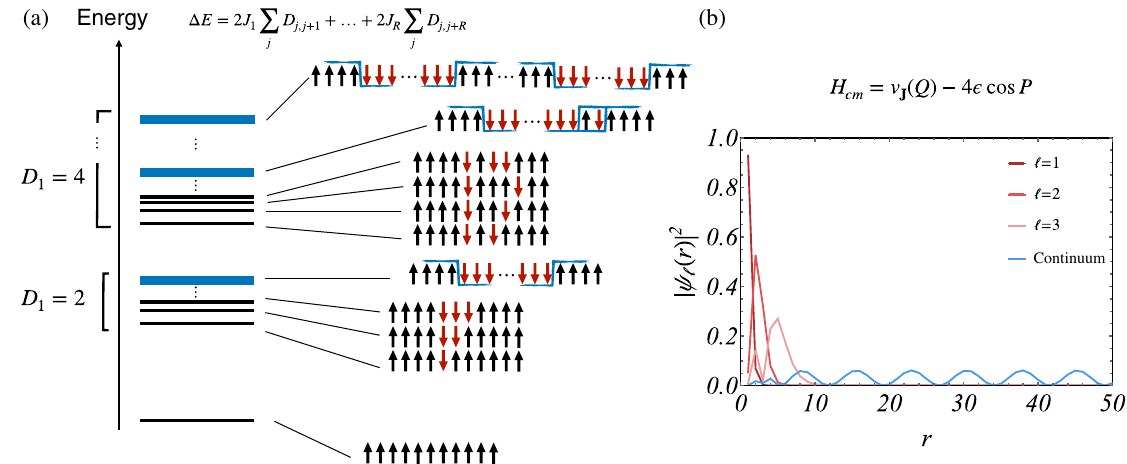
FIG. 8. (a) Sketch of the eigenstates of the Floquet Hamiltonian H F for ϵ → 0 . The vertical axis represents the excitation energy Δ E above the Floquet ground state. (b) Selection of eigenstates of the two-body problem (47) in the center-of-mass frame, for J r ≤ R ¼ 10 , α ¼ 3 , and ϵ ¼ 0 . 1139